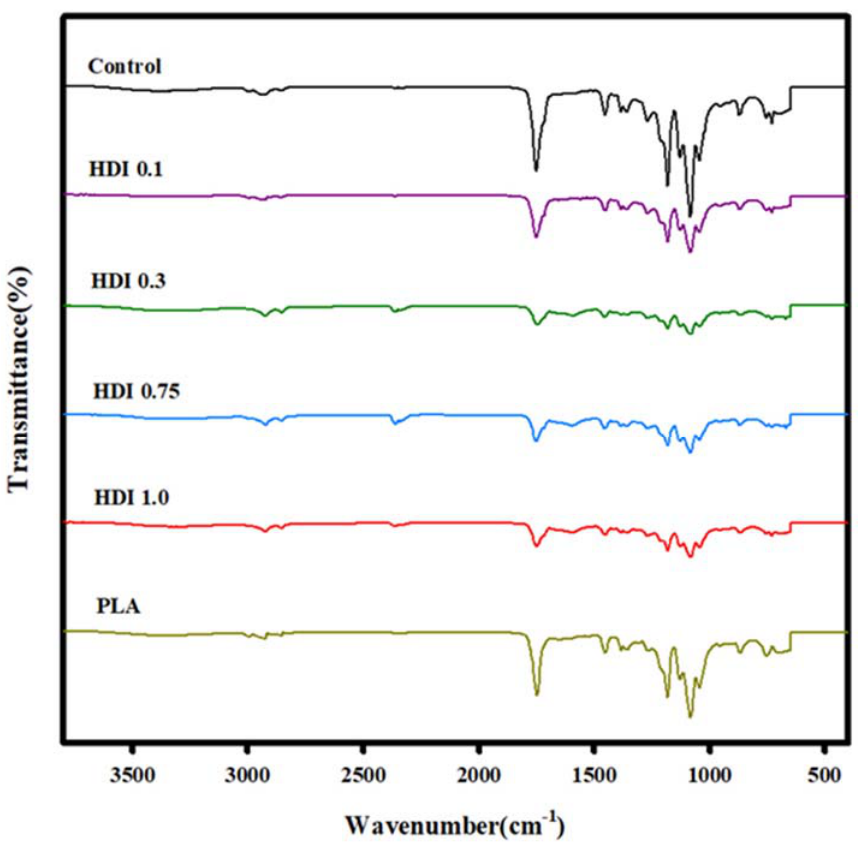
Figure 2. FTIR spectra of neat PLA, control, and blend specimens prepared with various HDI con ‐ tents.